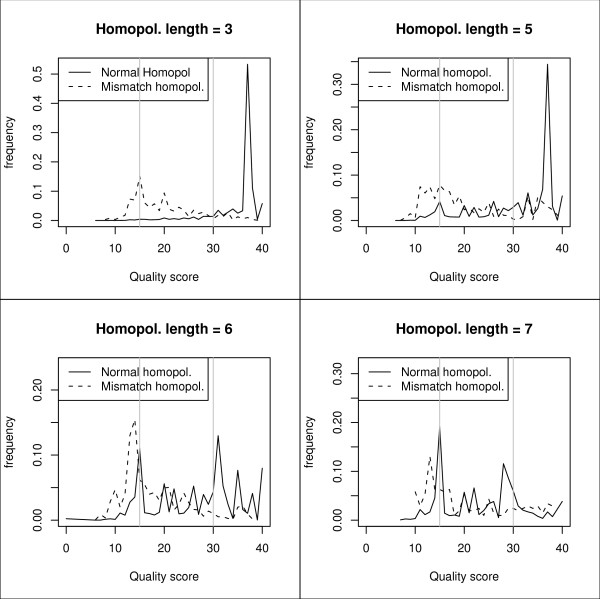
Influence of quality score (Q) on homopolymer accuracy. Distribution of homopolymer related quality scores (Q score). The normal homopolymer Q score distribution is determined by making a distribution of the Q score of the homopolymer base; the mismatch homopolymer Q score distribution is determined by making a distribution of the Q score of the base preceding a homopolymer related deletion or the Q score of a homopolymer related inserted base. Distributions are shown for homopolymers with length 3, 5, 6 and 7 bp. The grey vertical lines are drawn at a Q score of 15 and 30. Distributions are based on data from the two BRCA runs.